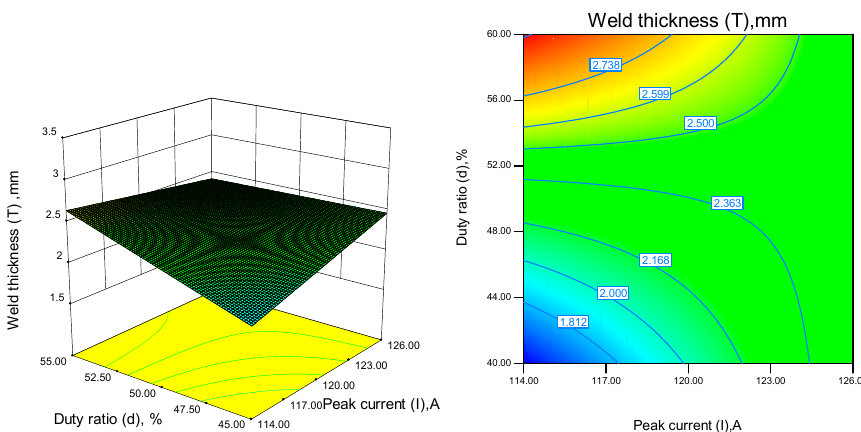
Figure 16. Interaction of peak current and duty ratio on weld thickness.